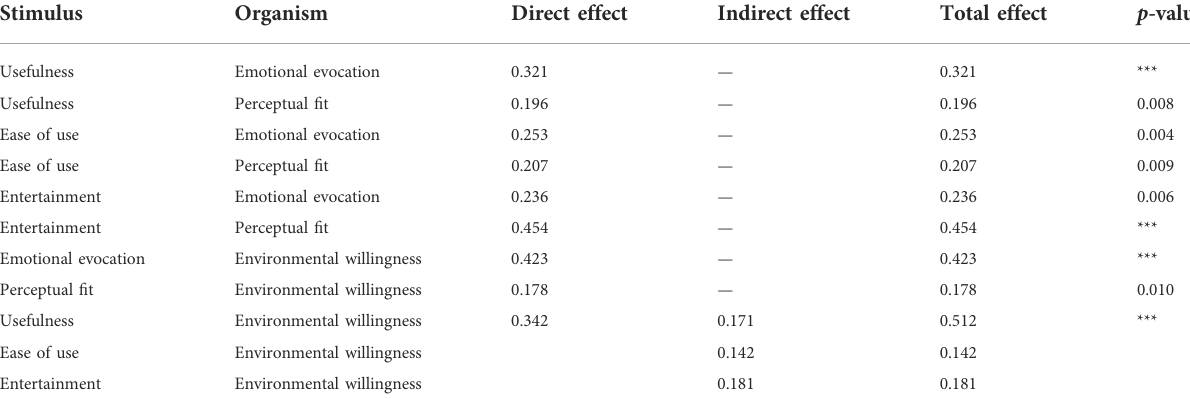
TABLE 3 Results of the model analysis of factors in fl uencing science short videos on users ’ environmental willingness.